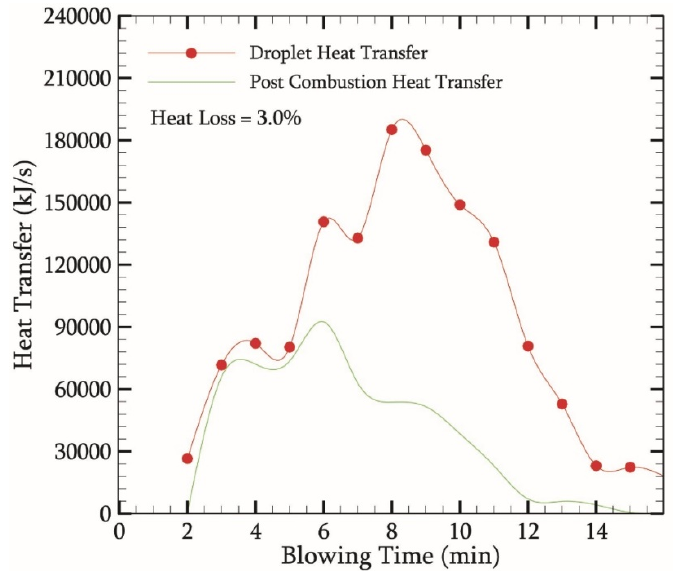
Figure 9. Droplet and post-combustion heat transfer rate throughout the blowing period for a heat loss of 3%.